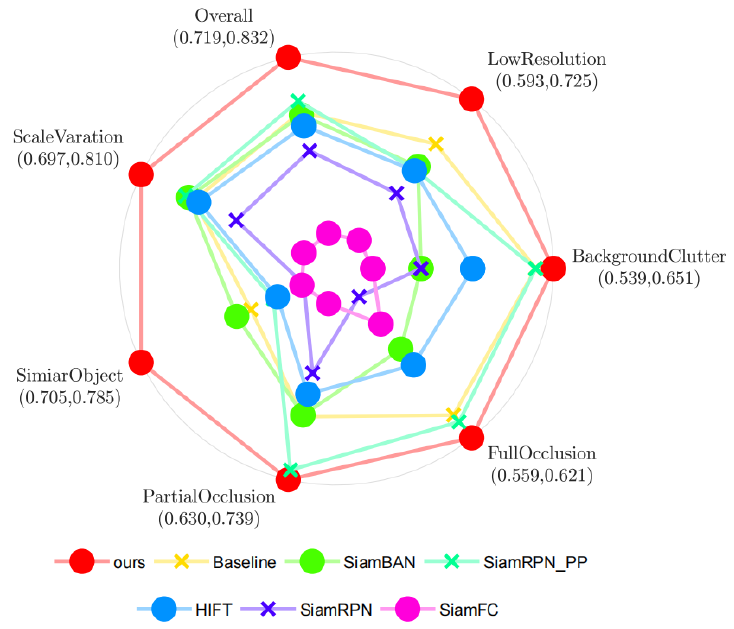
Figure 7. Precision scores of different attributes on the UAV123 data set. Take Overall as an example. In (0.719,0.832), 0.719 represents the algorithm with the lowest precision under this attribute, and 0.832 represents the algorithm with the highest precision under this attribute.